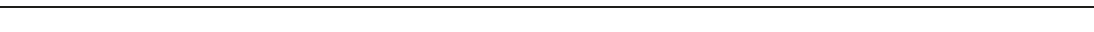
Fig. 2 Adenosine-induced suppression of endothelial in fl ammation requires adenosine uptake. a Western blot detection and densitometric quanti fi cation of adhesion molecule expression in HUVECs. HUVECs, pretreated for 30 min with both 5 µ M ZM 241385 and 5 µ M MRS 1754 were incubated with 100 µ M adenosine for 30 min and then stimulated with TNF- α at 10 ng/ml for 4 h ( n = 4). b Western blot detection and densitometric quanti fi cation of adhesion molecule expression in HUVECs. HUVECs, transiently transfected with control or A 2A R siRNA, were pretreated for 30 min with 100 µ M adenosine and then stimulated with 10 ng/ml TNF- α for 4 h ( n = 4). c Western blot detection and densitometric quanti fi cation of adhesion molecule expression in HUVECs. HUVECs, transiently transfected with control or A 2B R siRNA, were pretreated for 30 min with 100 µ M adenosine and then stimulated with